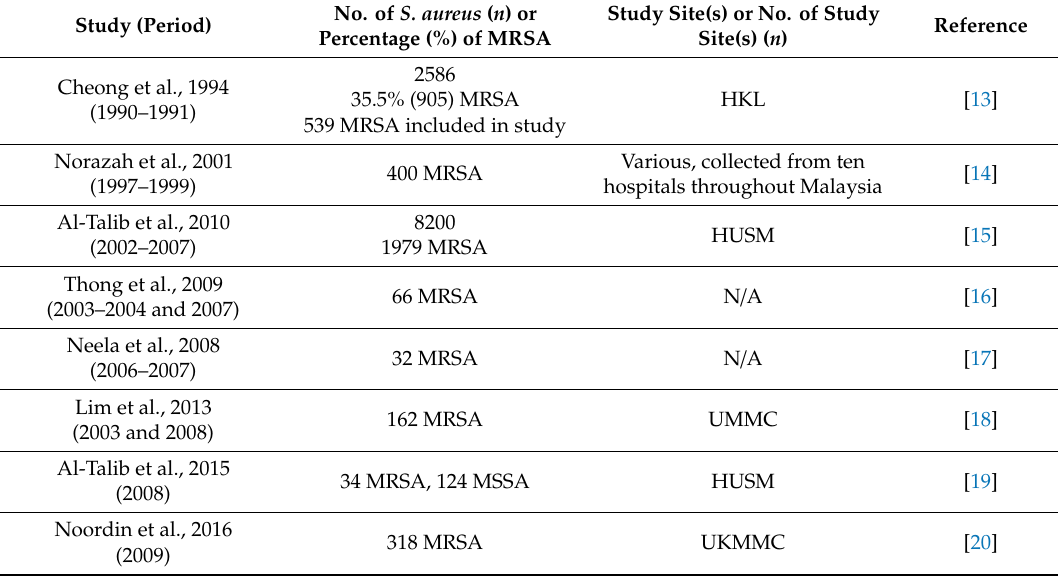
Table 2. Reported clinical Staphylococcus aureus studies in